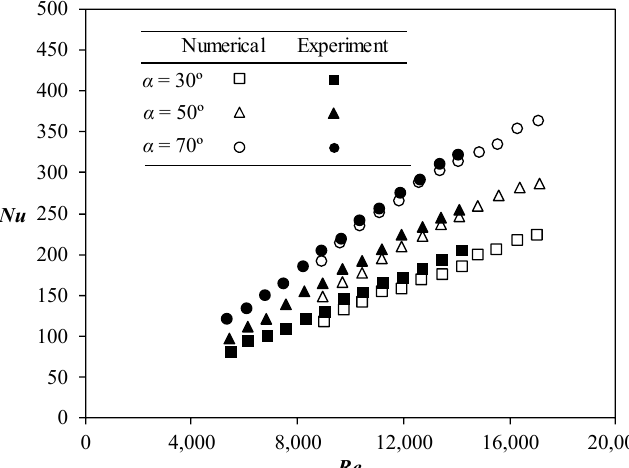
Figure 11. Nusselt number for numerical and experimental results.